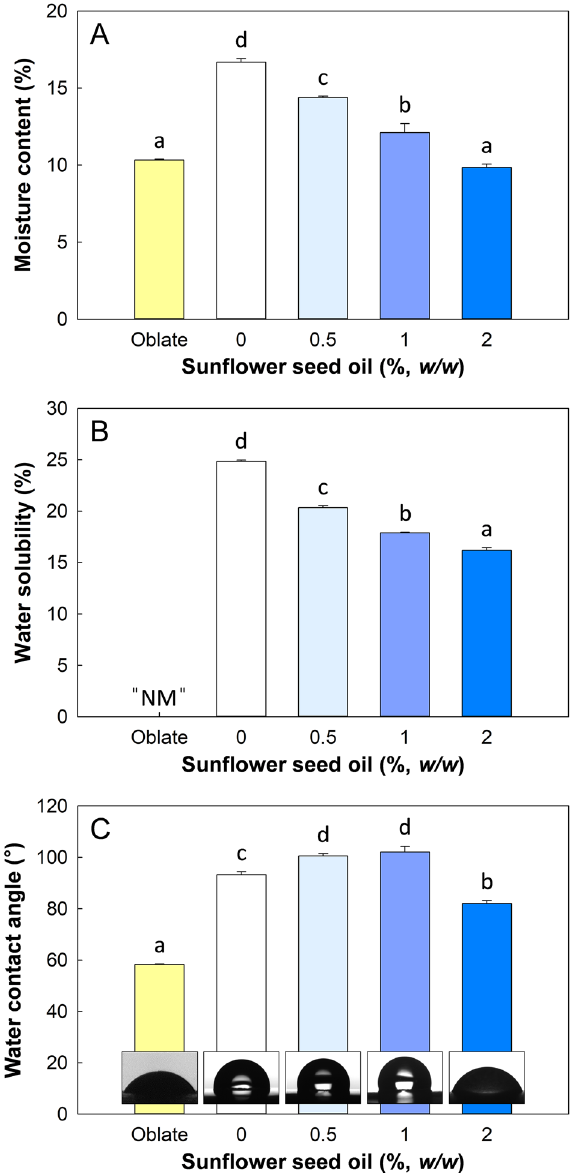
Figure 5. ( A ) Moisture content, ( B ) water solubility, and ( C ) water contact angle of oblate, GG/MBS, and SSO/GG/MBS composite films. Data are expressed as mean ± standard deviation of three replicates. Different lowercases ( a – d ) indicate significant differences ( P ≤ 0.05) by Duncan’s multiple range tests. NM not measurable because of disintegration of the film in water. GG guar gum, MBS mung bean starch, SSO sunflower seed